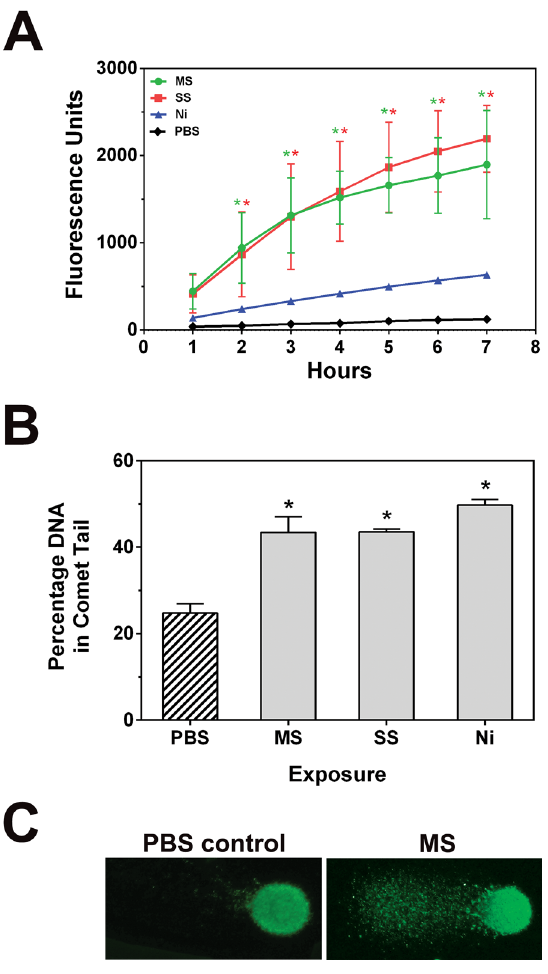
Figure 5. Intracellular ROS production in cells following treatment with welding fumes. A. RAW 264.7 cells were pre- treated with DCFH-DA, exposed to 50 m g/ml suspensions of welding fumes, and plates were read each hour to measure intracellular ROS. Error bars represent the mean 6 SD (n=3). *, p , 0.05 compared to PBS controls at that time point. B. A comet assay was used to examine DNA damage. Cells were treated with 50 m g/ml suspensions of welding fumes for 3 h, washed and scraped into PBS, added to glass slides with agarose, then lysed and subjected to electrophoresis. SYBR green was added to stain double-stranded DNA. Images were acquired using fluorescence microscopy and a 40x objective. Experiments were performed in duplicate and comets were measured by comparing the corrected nuclear region fluorescence to the corrected total cell fluorescence. This was converted to a percentage to indicate DNA damage. Error bars represent the mean 6 SD. *, p , 0.05 compared to PBS controls. C. Representative images of